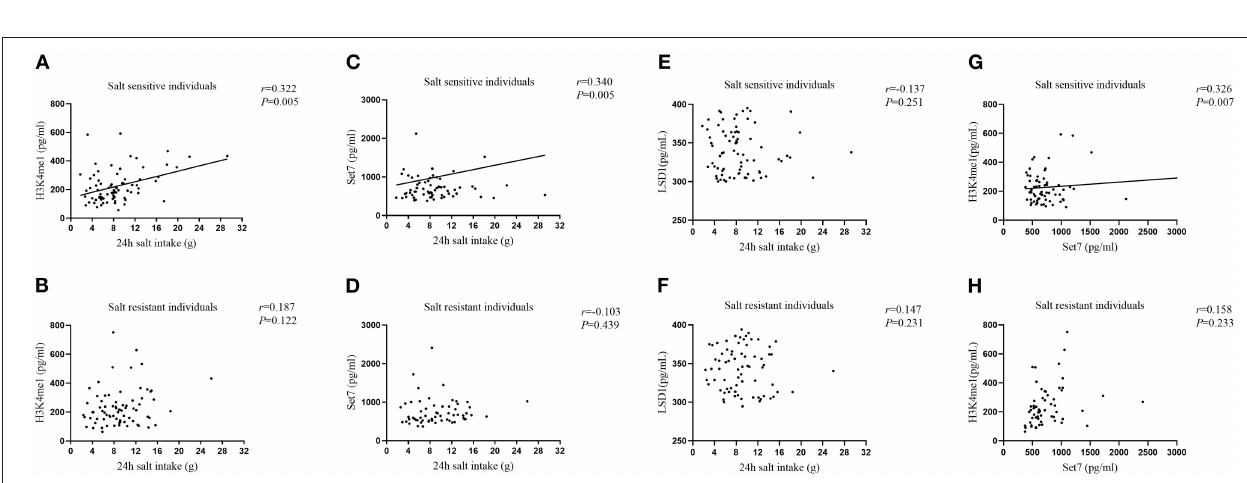
FIGURE 3 | Correlations of 24h salt intake with serum H3K4me1 in SS individuals (A) , H3K4me1 in SR individuals (B) , Set7 in SS individuals (C) , Set7 in SR individuals (D) , LSD-1 in SS individuals (E) , and LSD-1 in SR individuals (F) after adjusting age and gender. The correlation between serum H3K4me1 and Set7 in SS individuals (G) and in SR individuals (H) after adjusting for age and